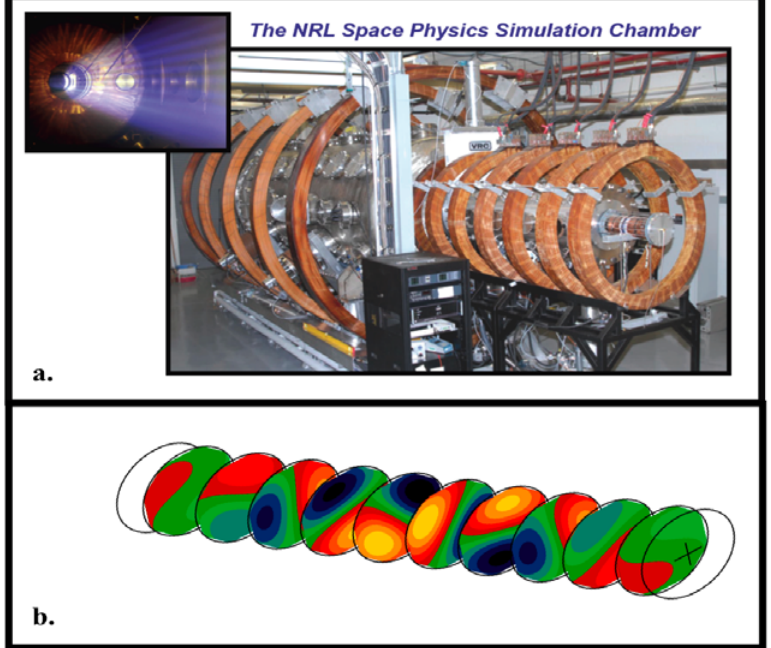
Figure 13. a. The main NRL Space Physics Simulation Chamber (SPSC). b. Finite length Taylor double helix plasma (B isosurfaces) for a length over radius of z